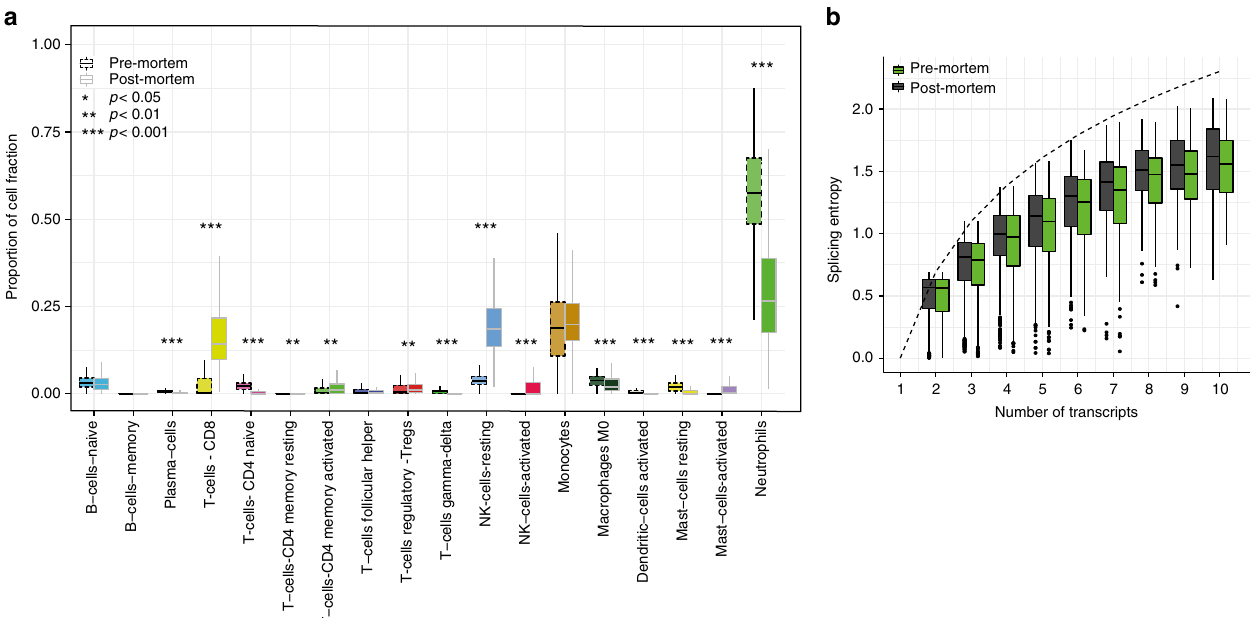
Fig. 7 Differential cellular composition and splicing entropy in blood. a Cellular composition analysis for 18 cell types shows an increase in NK-cells-resting and T-cells-CD8 and decrease in Neutrophils composition from pre- to post-mortem blood samples. b Splicing entropy in pre- and post-mortem samples for genes of different number of